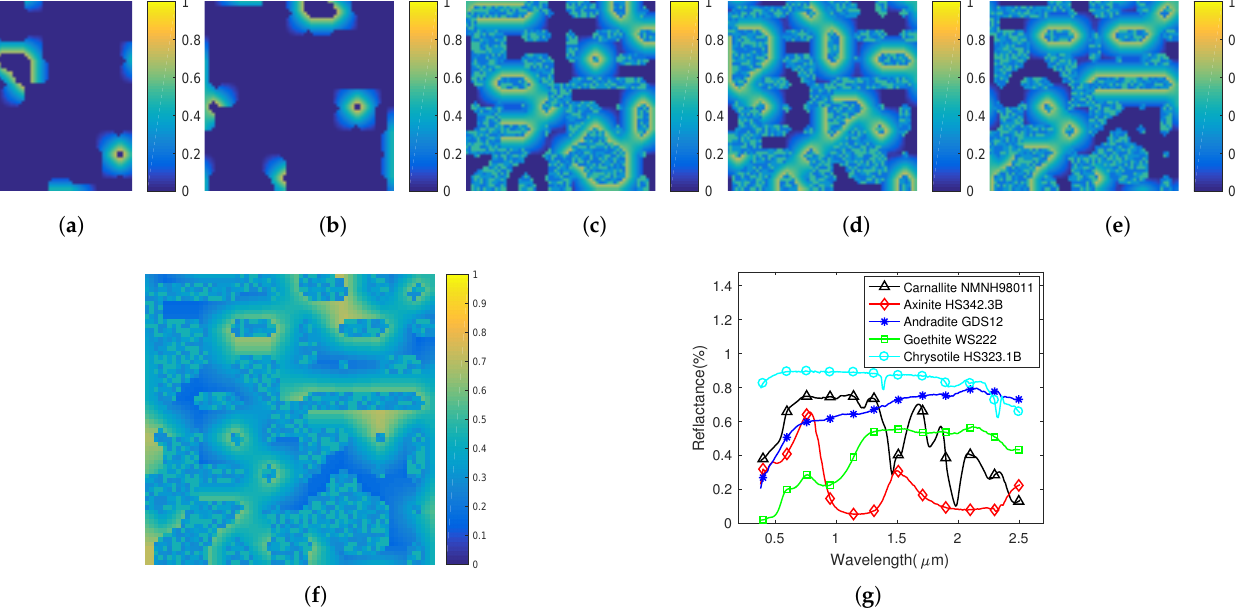
Figure 2. Example of the synthetic data. ( a – e ) Abundance maps. ( f ) the 188th band of a 64 × 64 synthetic data with signal-to-noise ration (SNR) of 25 dB. ( g ) Endmembers used to create synthetic data